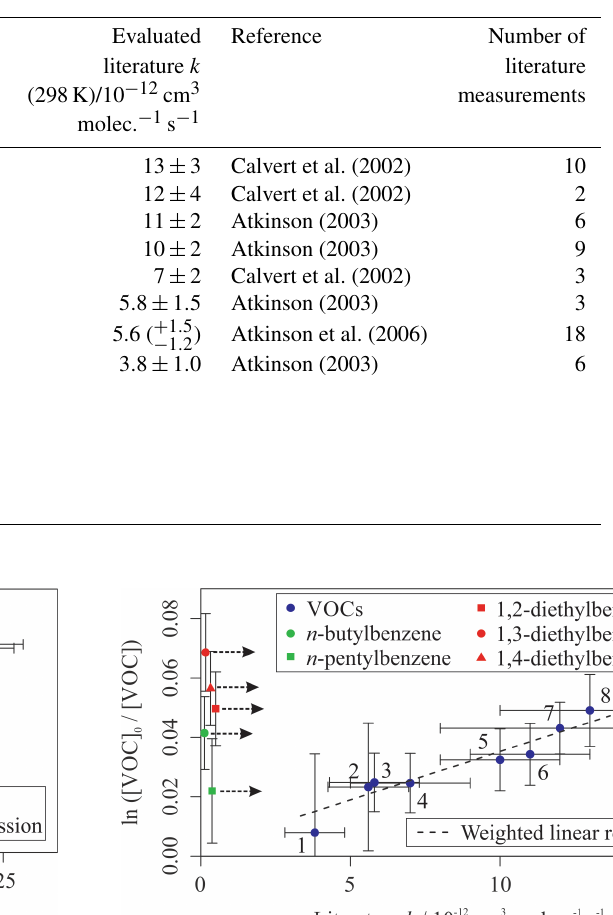
Table 3. Results of relative rate experiments, with evaluated literature data, for each VOC in Mixture 3, ordered by evaluated literature k value. The measured values presented here are the weighted averages of five individual experiments conducted with different mixture OH reactivities and 40ppbv NO. Five VOCs had no reported data for their reactions with OH.